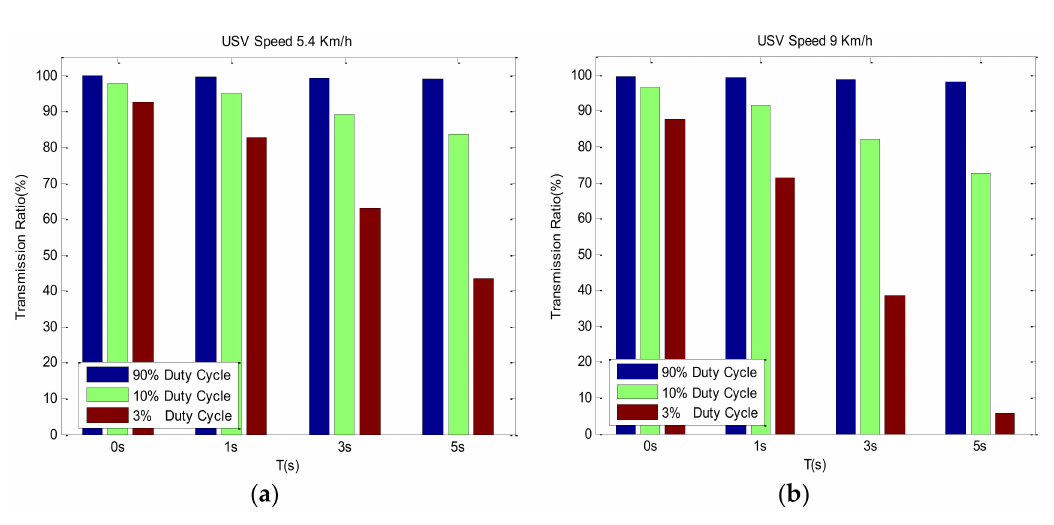
Figure 9. Simulations of transmission